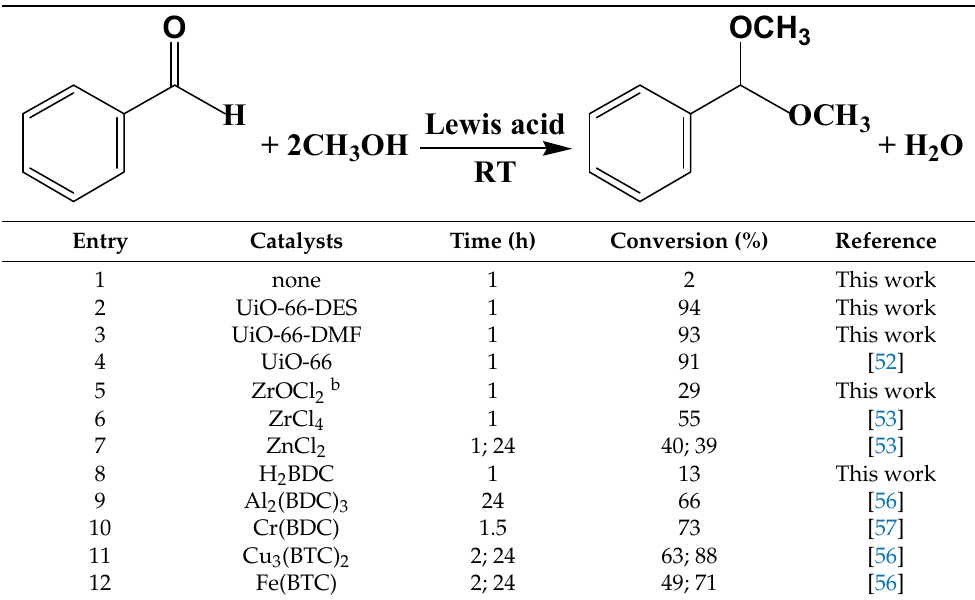
Table 1. Catalytic performance of benzaldehyde acetalization and methanol over various MOFs and Lewis acid catalyst a .